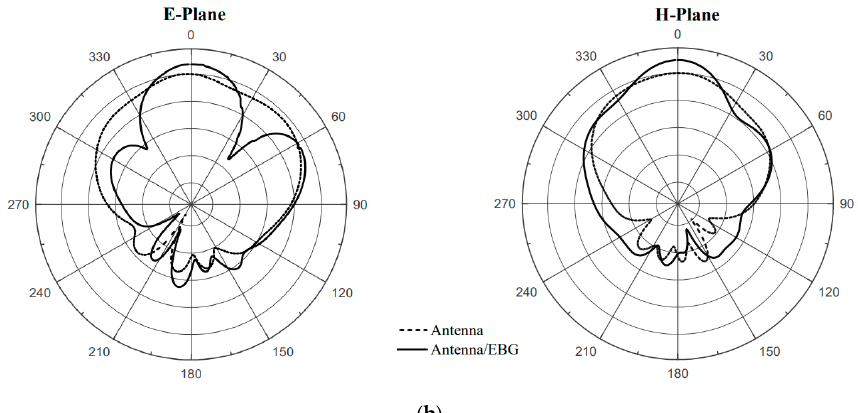
Figure 10. Radiation patterns: ( a ) in the anechoic chamber. ( b ) measured for two planes (E-plane; H-plane) radiation patterns at 26 GHz.